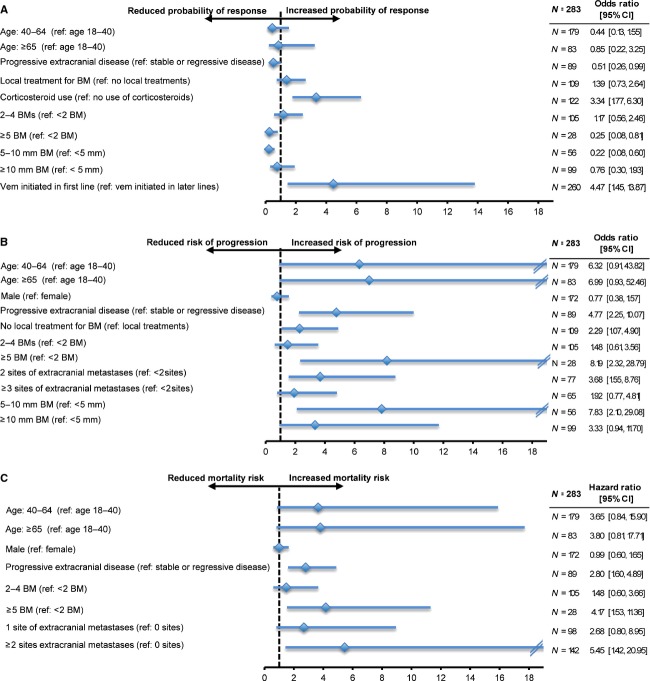
Factors associated with intracranial treatment response (A), intracranial disease progression (B), and mortality (C).